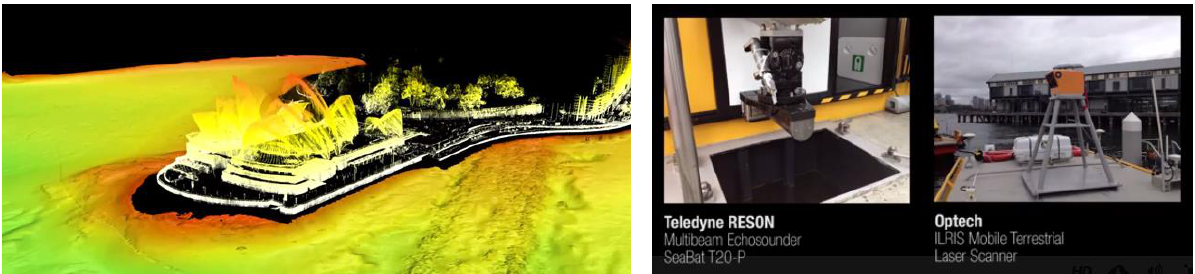
Figure 2. Combined laser and bathymetric survey of Sydney harbour